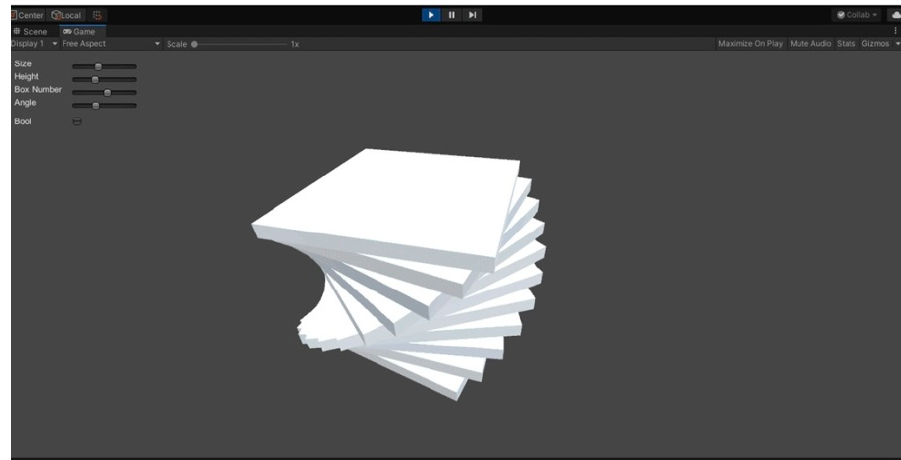
Figure 7. Box model mesh data are generated inside Grasshopper3d parametric-modeling tool using size, height , box number , and rotation angle parameters (upper left corner).